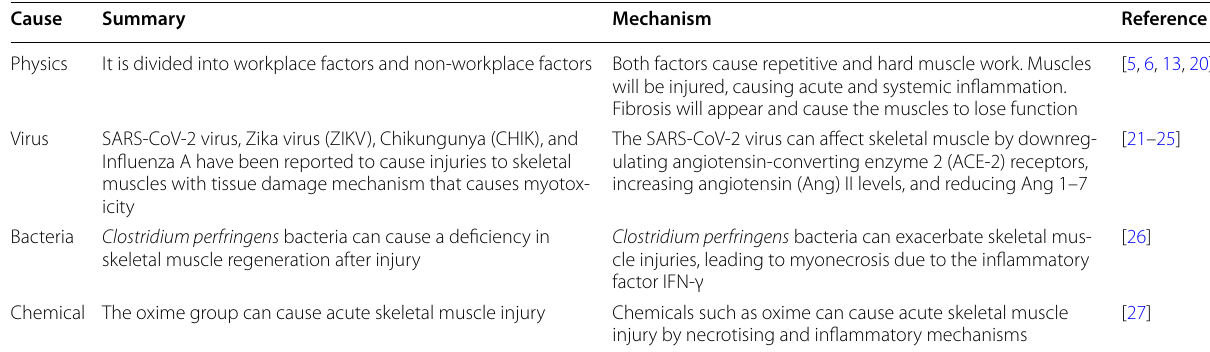
Table 1 The cause of skeletal muscle